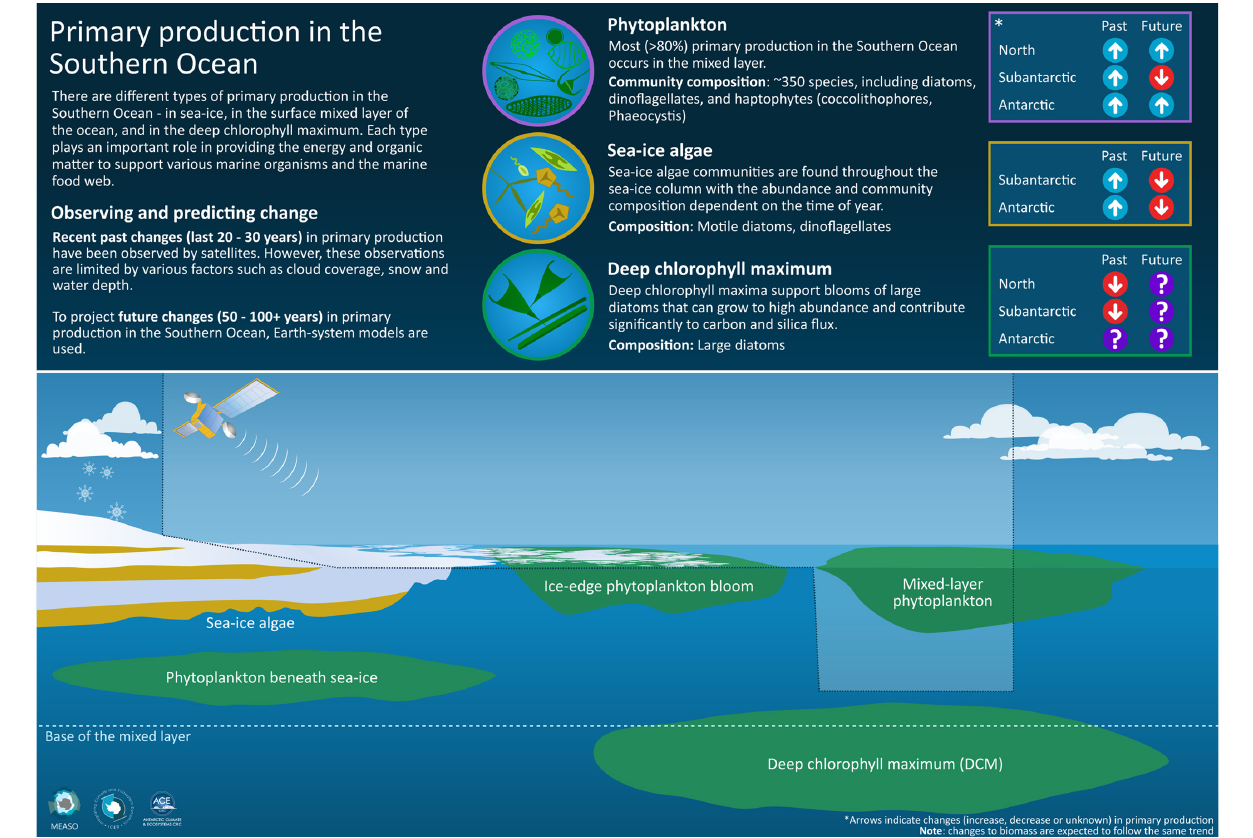
Frontiers in Ecology and Evolution |